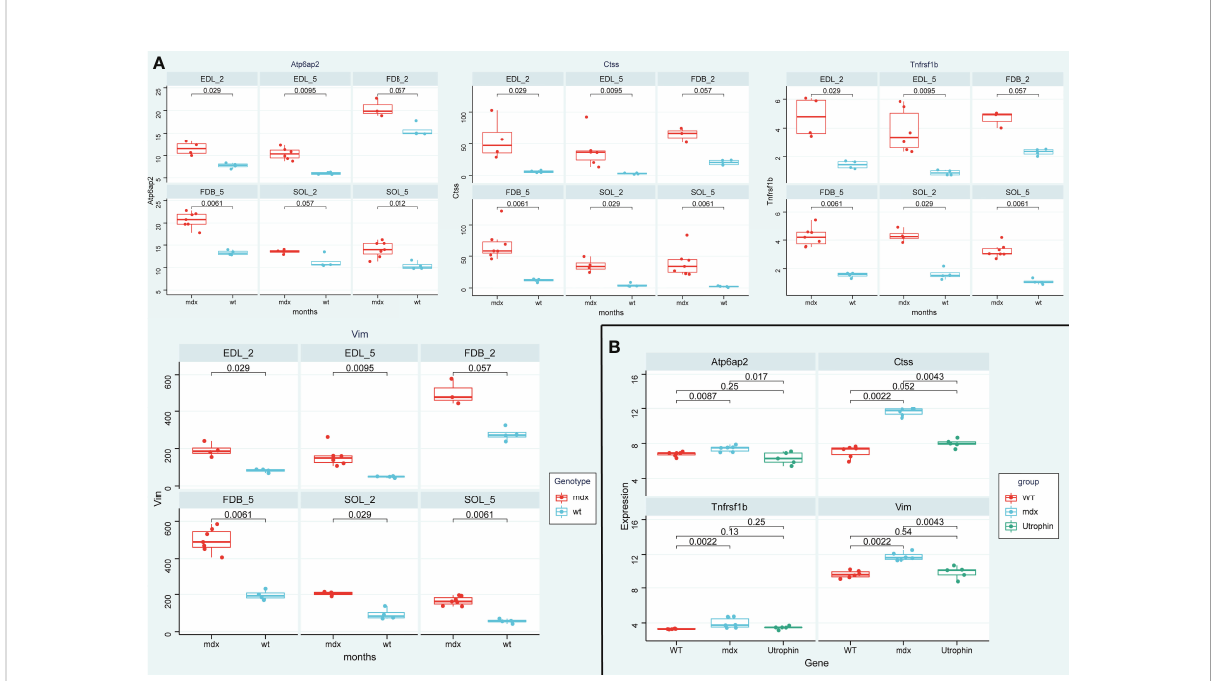
FIGURE 13 The expression level validation of the four genes in mdx mouse and utrophin groups. (A) A boxplot evaluation of the diagnostic effectiveness of the 4 genes in in the three mdx mouse muscles at 2- and 5-month old mice, including the extensor digitorum longus (EDL), the fl exor digitorum brevis (FDB), and the soleus (SOL). (B) A boxplot evaluation of the diagnostic effectiveness of the 4 genes in utrophin